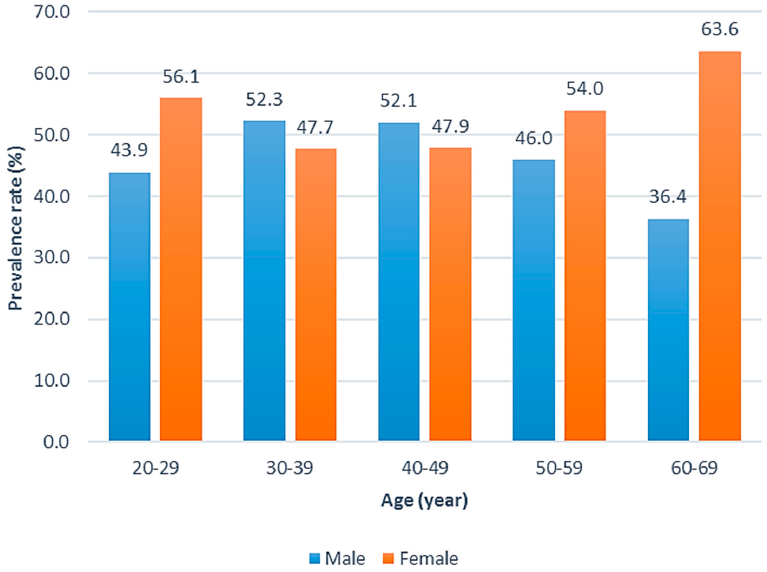
Figure 1. Prevalence of depressive symptoms in men and women.